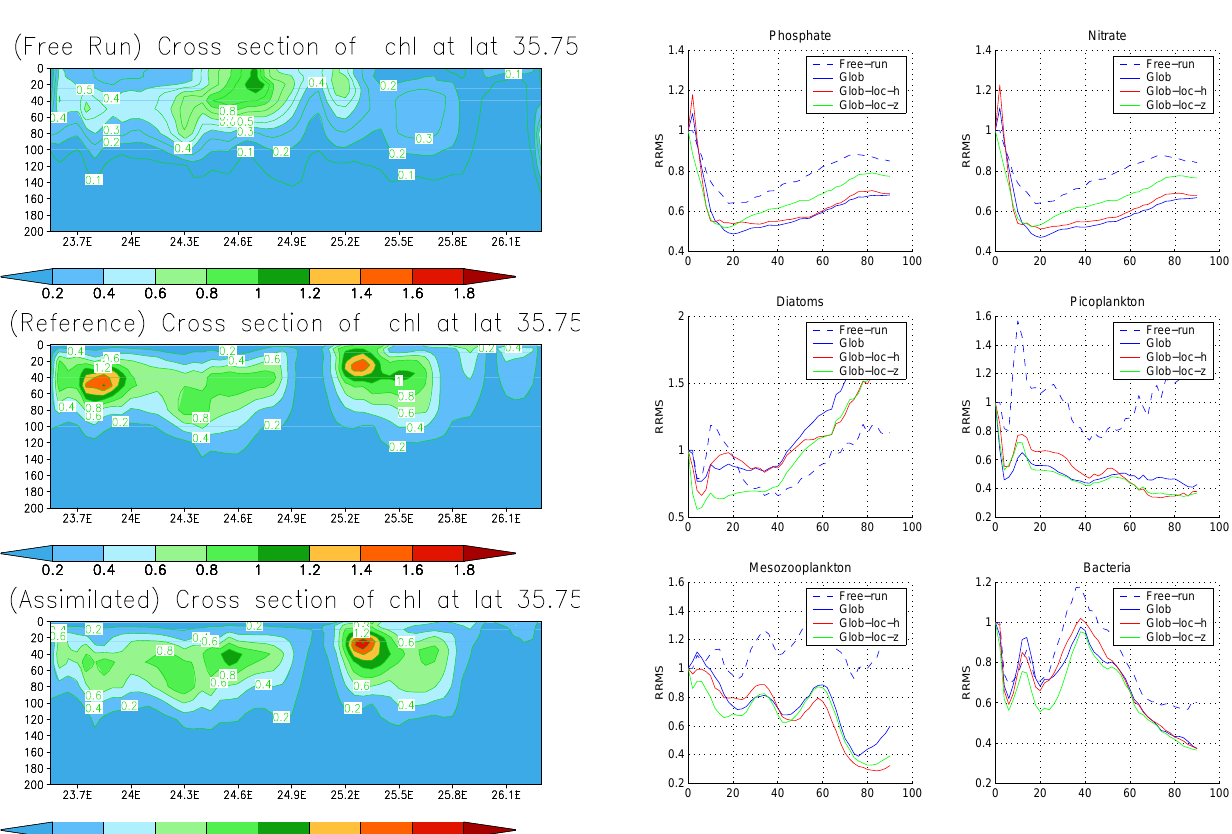
Fig. 12. Evolution in time of phosphate, nitrate, diatoms, picoplank- ton, mesozooplankton and bacteria RRMS from the SFPLEK filter assimilating sea color data using global EOFs, global-local EOFs from 4 horizontal and 3 vertical sub-domains (as shown in Fig